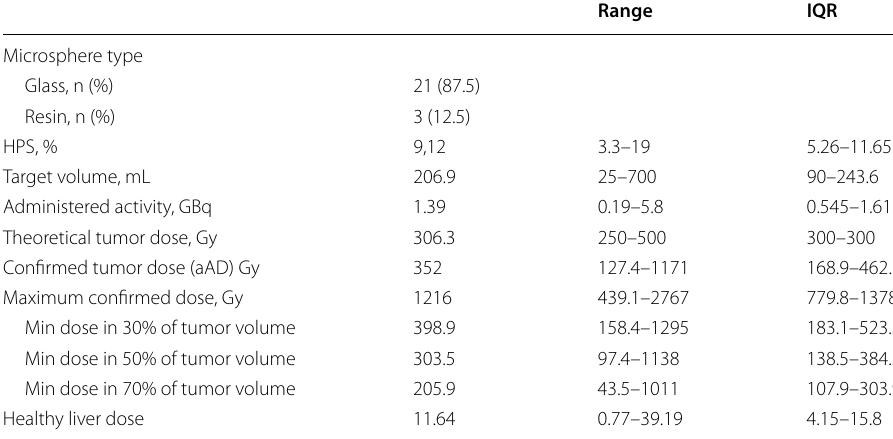
Table 2 Treatment